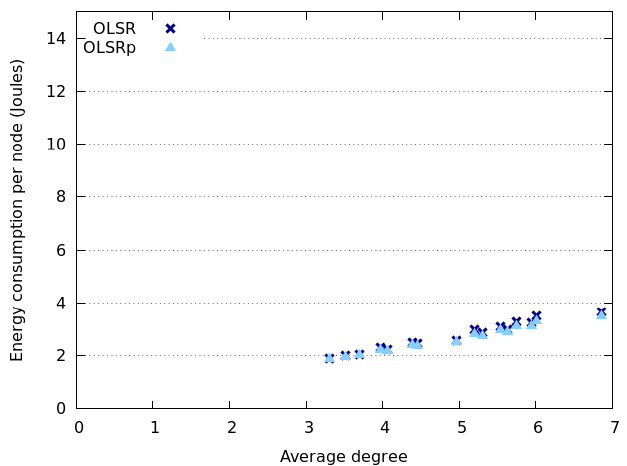
Figure 15. Energy consumption versus network degree when nodes follow a RPGM